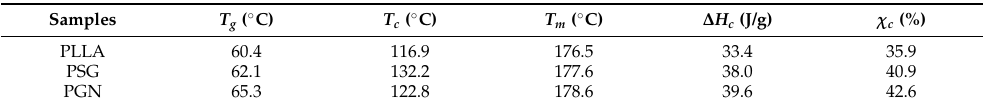
Table 1. Calorimetric data derived from the DSC cooling curves and heating curves for the PLLA, PSG and PGN